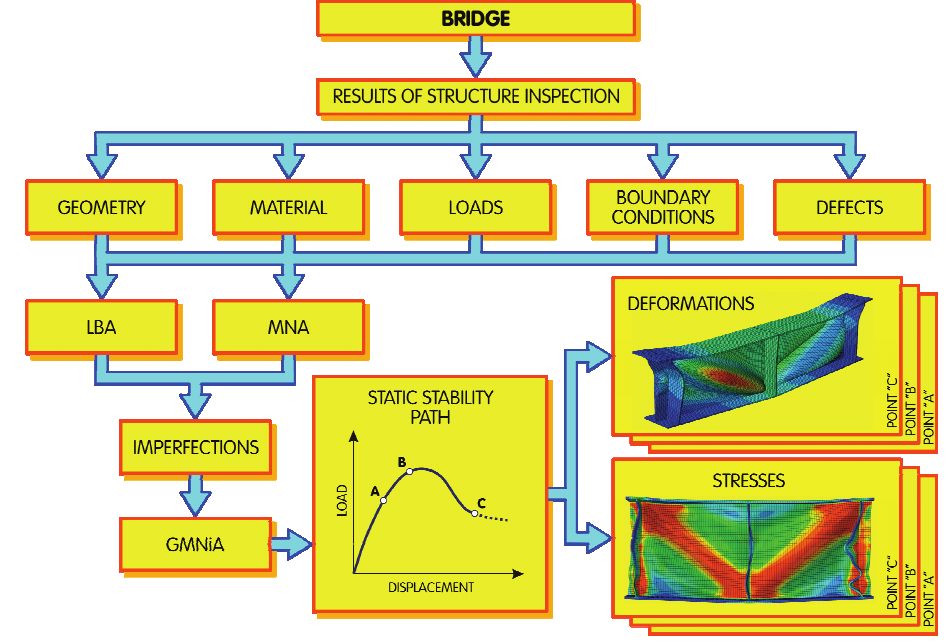
Fig. 1. Flow chart of nonlinear FEM analyses of bridge plate girders with defects, in consecutive phases of girder behaviour until failure (Ku ż awa [8])